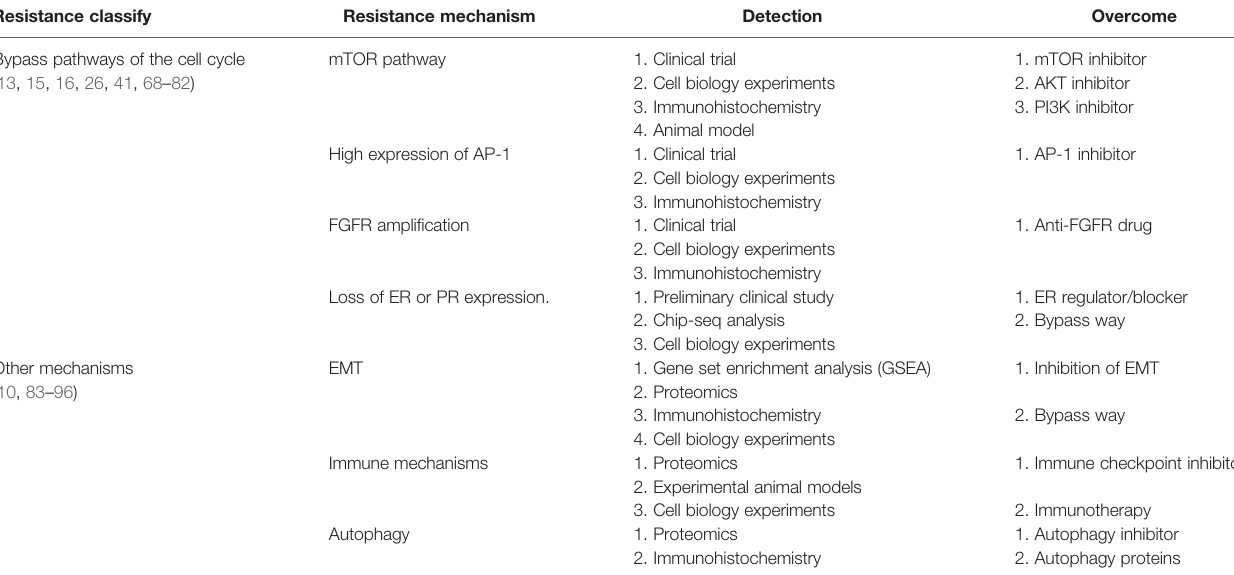
TABLE 2 | Mechanisms of acquired resistance to CDK4/6 inhibitors: Indirect cell cycle mechanisms. Resistance